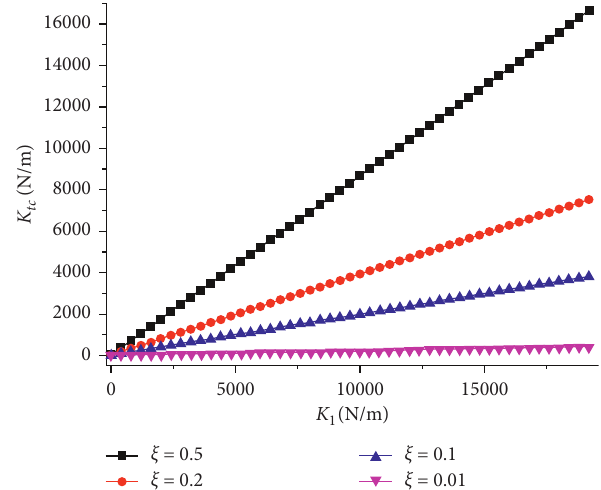
Figure 3: The critical control gain K tc of a single DOF VIS with time-delay control for chaotification versus different equivalent linear stiffnesses K and different damping ratios ξ . 1